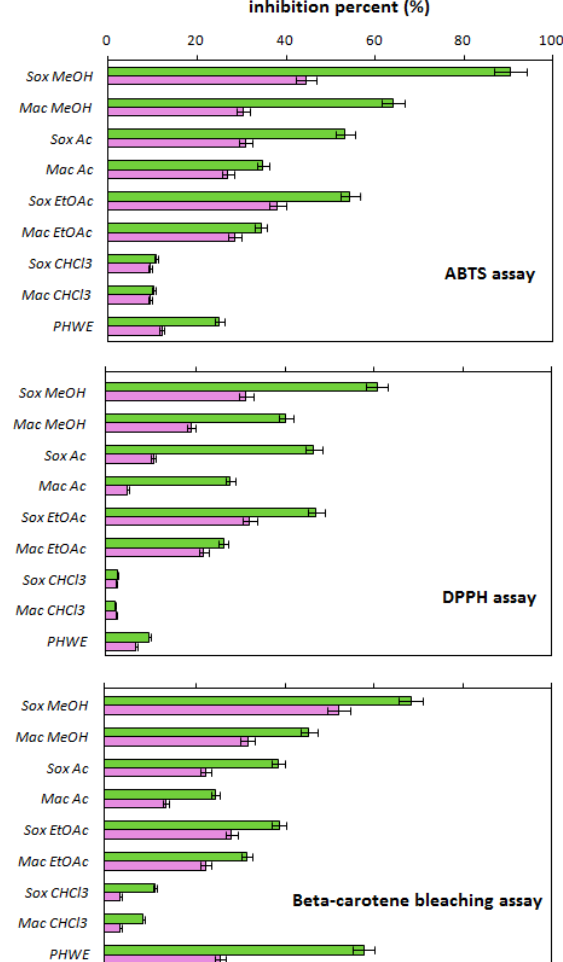
Figure 2. Comparison of the antioxidant activity of white onion scale extracts (green bars) obtained by the pressurized hot water extraction, extraction in the Soxhlet apparatus, and maceration using different extractants (methanol, acetone, ethyl acetate or chloroform) and by the quercetin solutions (pink bars) with the same quercetin concentrations as those in the onion scale extracts.